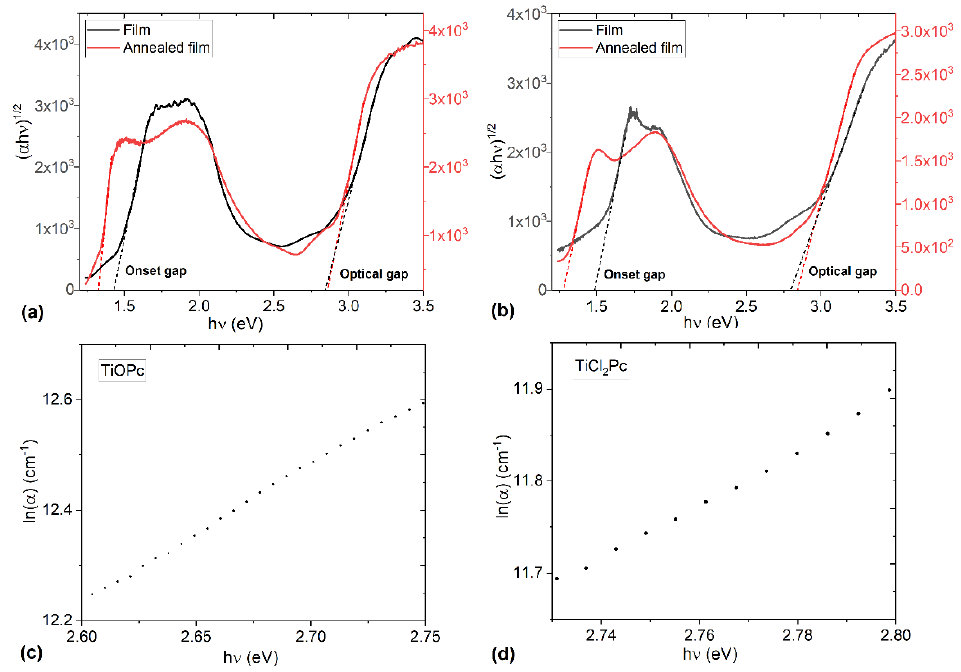
Figure 7. Variation in ( α h ν ) 1/2 with h ν for ( a ) TiOPc and ( b ) TiCl 2 Pc films before and after annealing. Variation in ln( α ) with h ν for ( c ) TiOPc and ( d ) TiCl 2 Pc films. Table 4. Onset gap and optical gap ( E optical g ) for the TiOPc and TiCl 2 Pc films. Thin Film Onset Gap (eV) Optical Gap (eV)